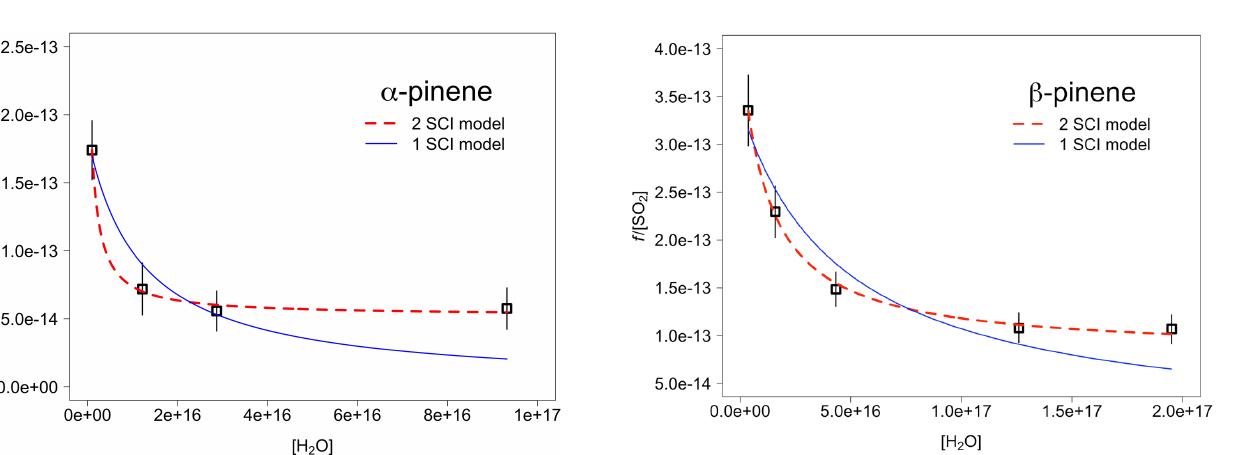
Figure 3. Application of a 2-SCI model fit (Eq. 4) and a single-SCI model fit (Eq. 1) to the measured values (open squares) of f / [SO 2 ] for α -pinene. From the fit we derive relative rate constants for re- action of the α -pinene-derived SCI, SCI-A and SCI-B with H 2 O ( k 3 /k 2 ) and decomposition (( k d + L)/k 2 ) assuming that γ A = 0.40 and γ B = 0.60.